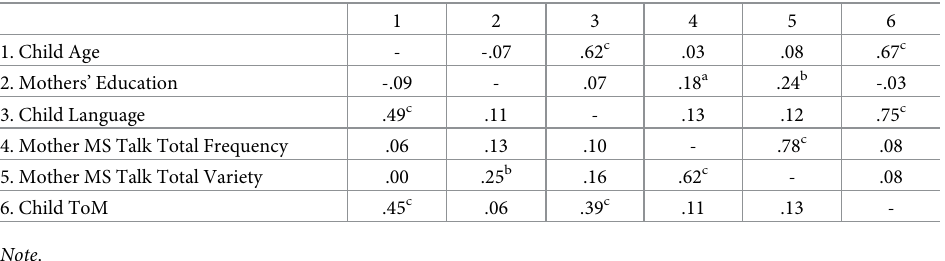
Table 3. Bivariate correlations between child age, maternal education, child language, mothers’ talk and child ToM abilities in Western (Above diagonal) and Chinese children (Below